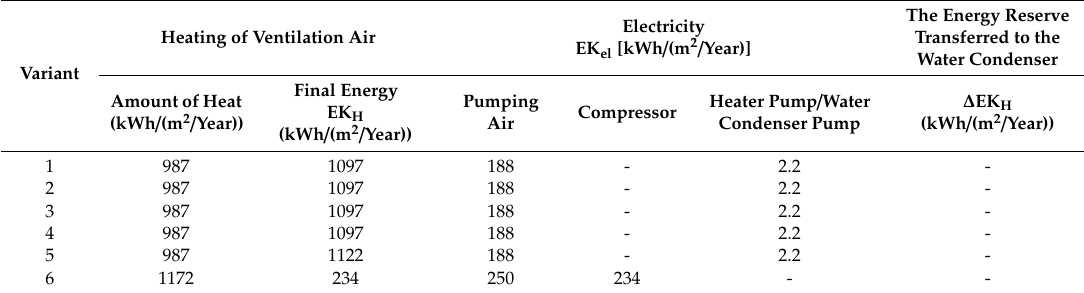
Table 5. Energy consumption calculation results—sports pool B1.